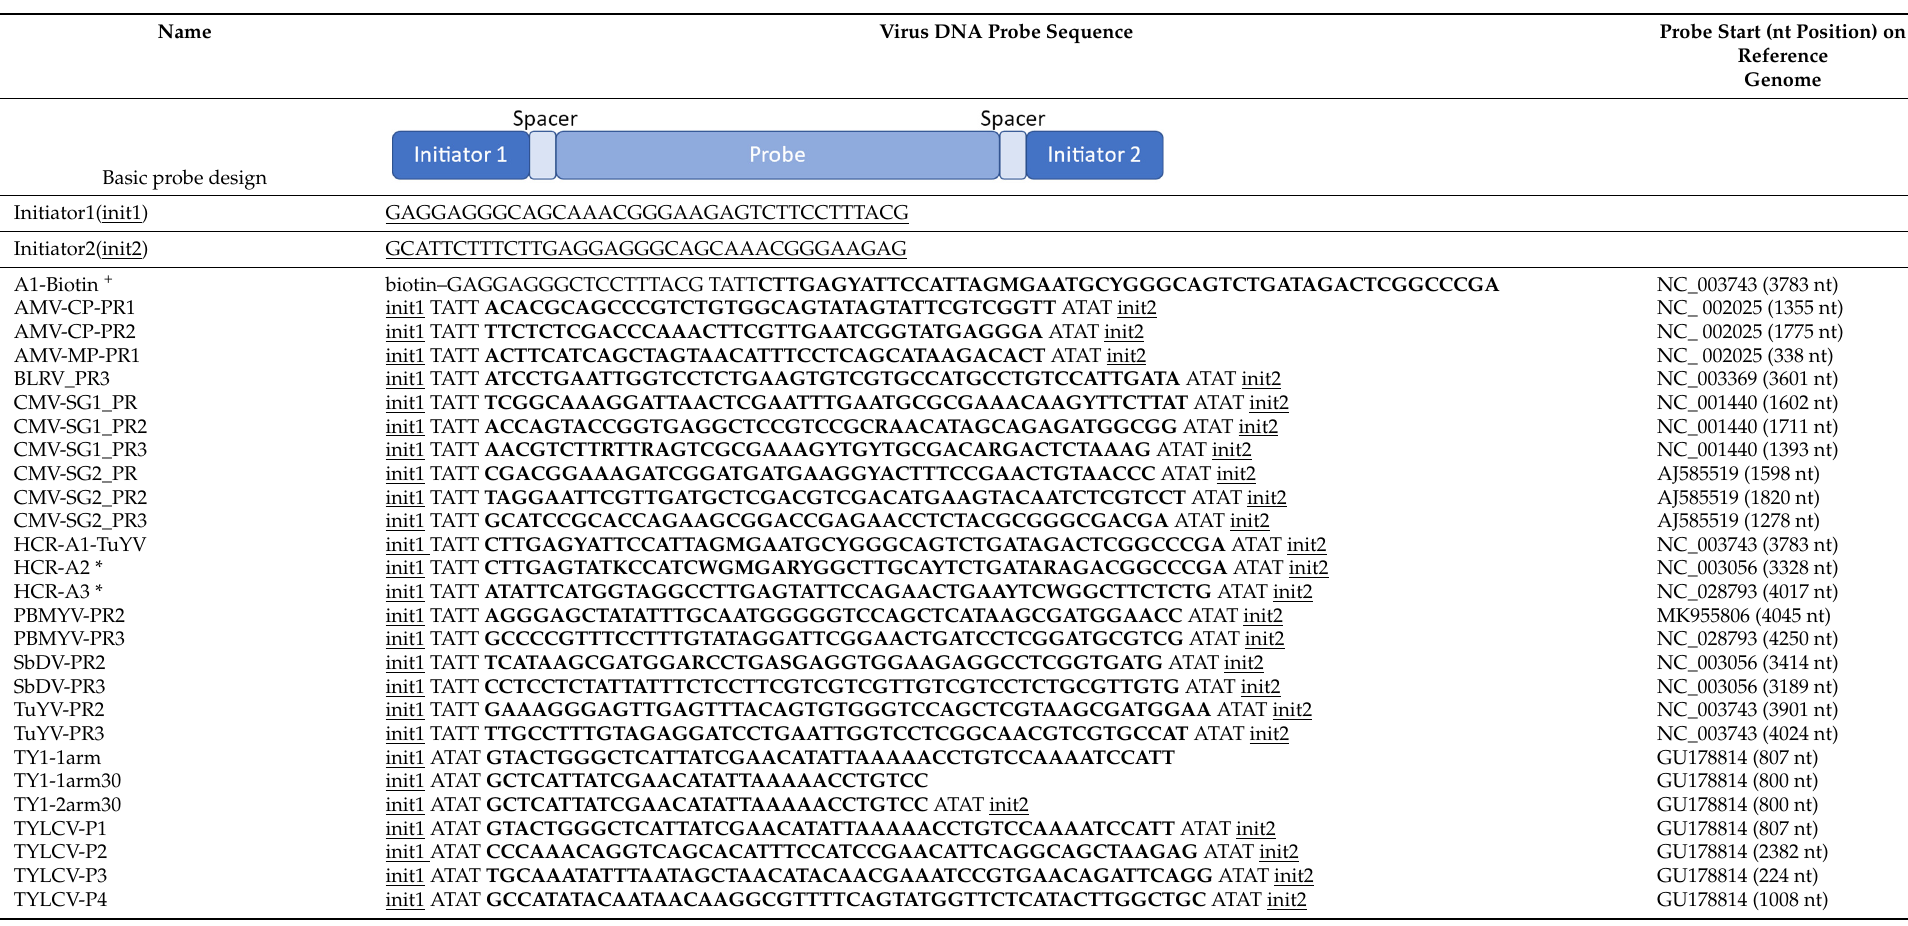
Table 1. The DNA probes and hairpins used in this study for the detection of plant viruses. Bold indicates the viral probe sequence and the underlined sequence on the hairpins is complementary to the initiator sequence on the probes.